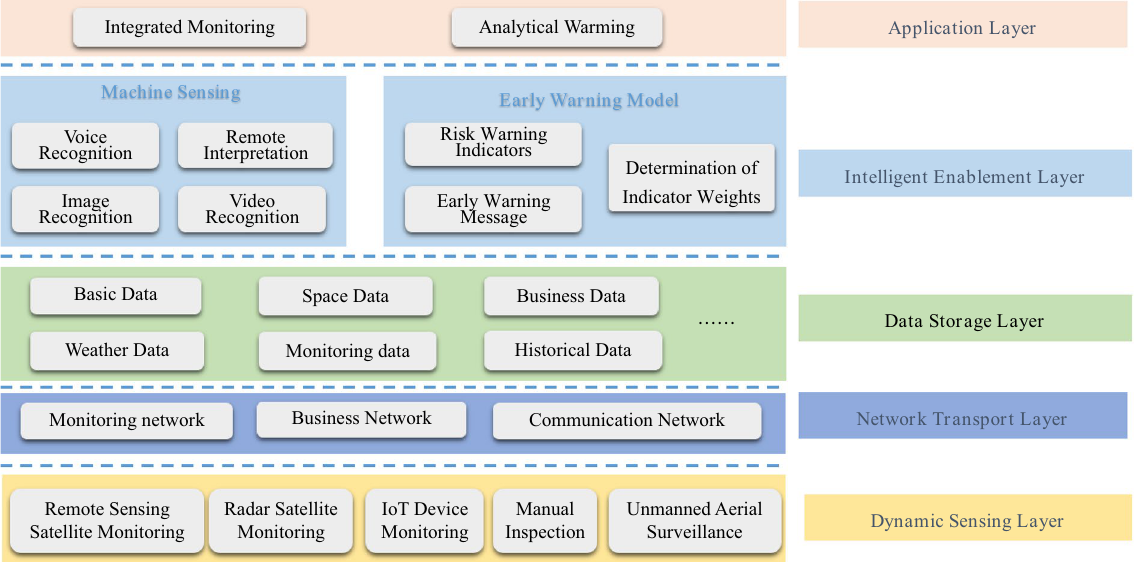
Figure 13. Framework of the intelligent monitoring and warning platform for soil and water conservation.